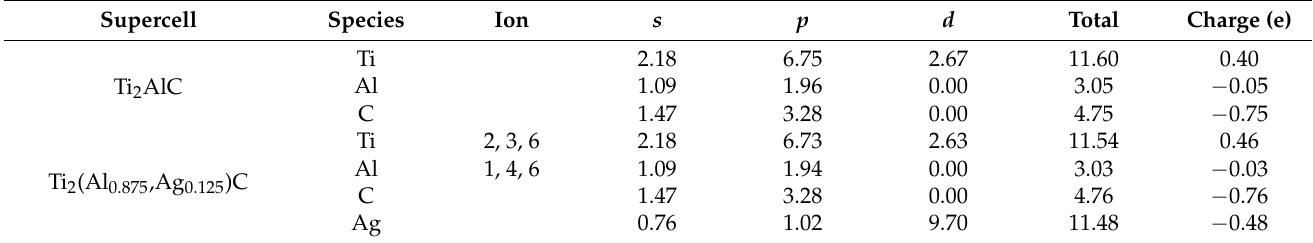
Table 2. Atomic orbital charge populations of Ti 2 AlC and Ti 2 (Al 0.875 ,Ag 0.125 )C supercells.